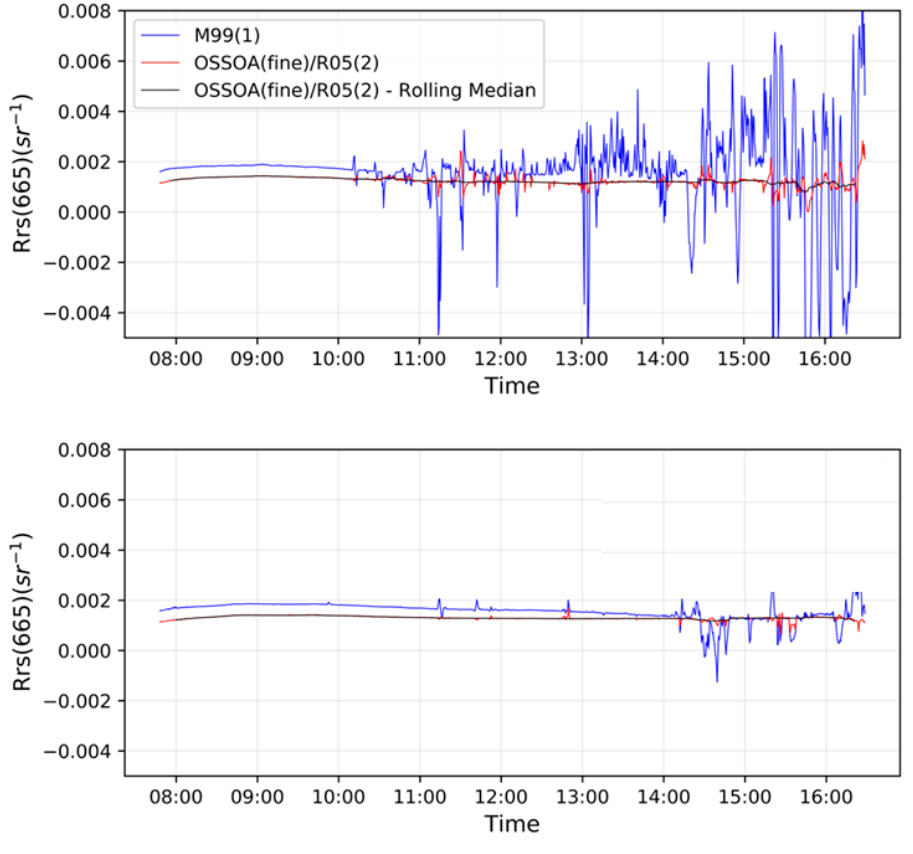
Figure 9. Comparison of R rs at 665 nm, obtained using (i) M99(1) method; (ii) OSOAA(fine) postprocessed with R05 method; (iii) OSOAA(fine) postprocessed with R05 method with a final application of a 15 min rolling median filter. Data presented for the 7th ( above ) and 8th ( below ) day of measurement.